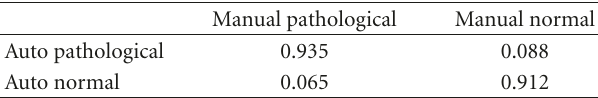
Table 7: Confusion matrix for the two correlations case (Training set).